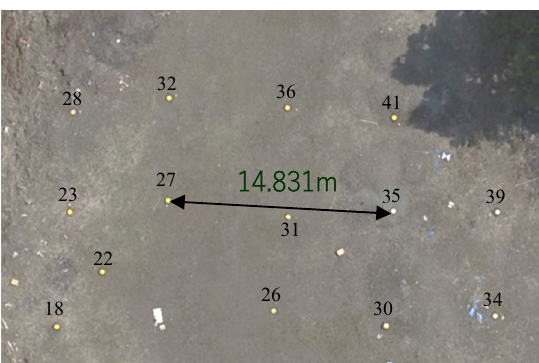
Figure 5. Given distance between 2 points